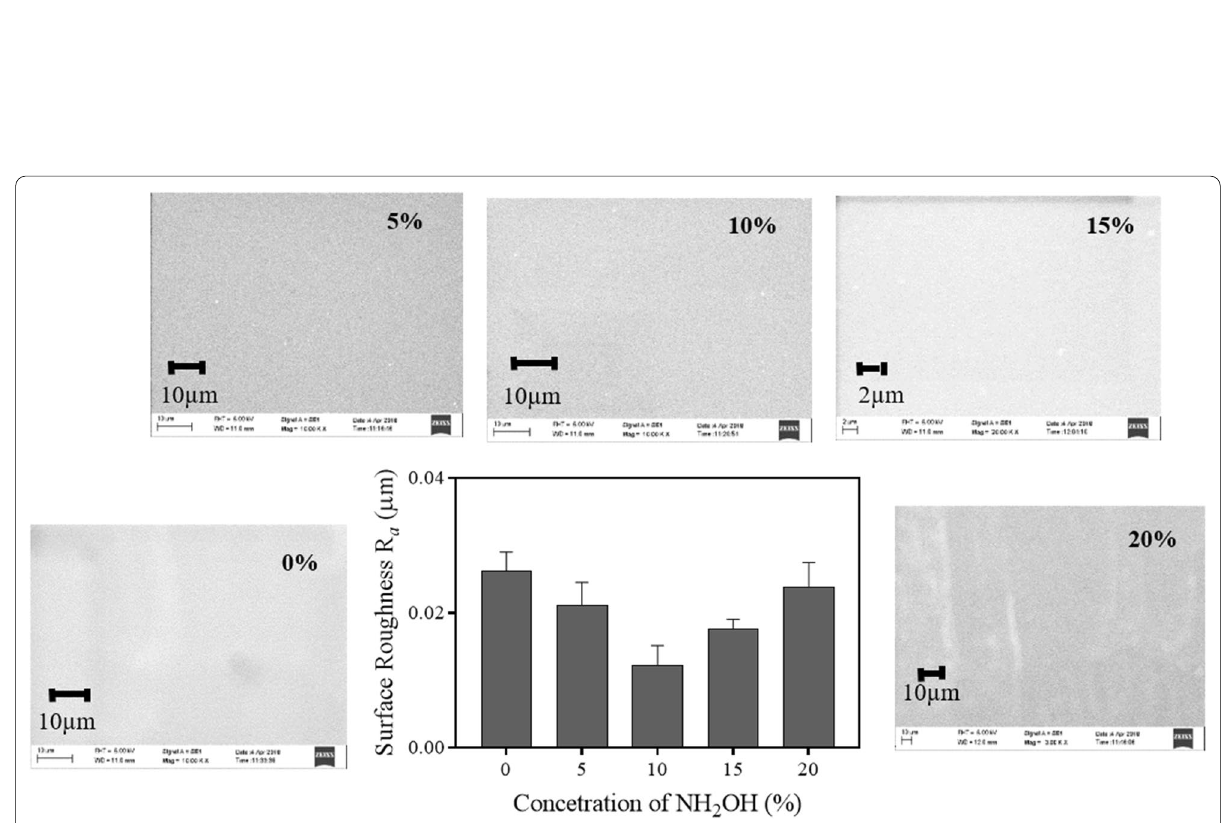
Fig. 40 Etched surface roughness (Ra) and corresponding surface morphologies of Si{110} in pure and different concentrations of NH 2 OH added 5 wt% TMAH at 70 1 °C [50] ±